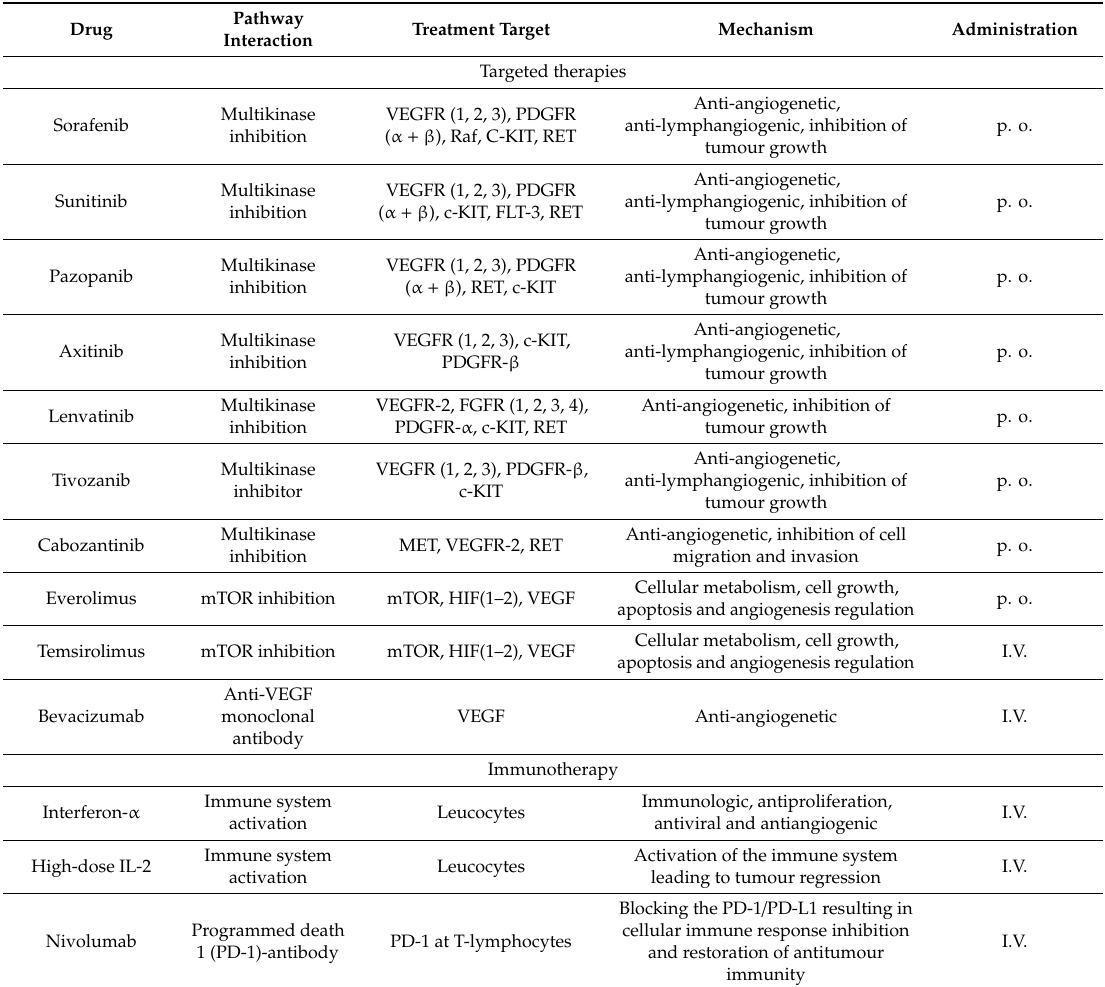
Table 3. Medical management of renal cell carcinoma